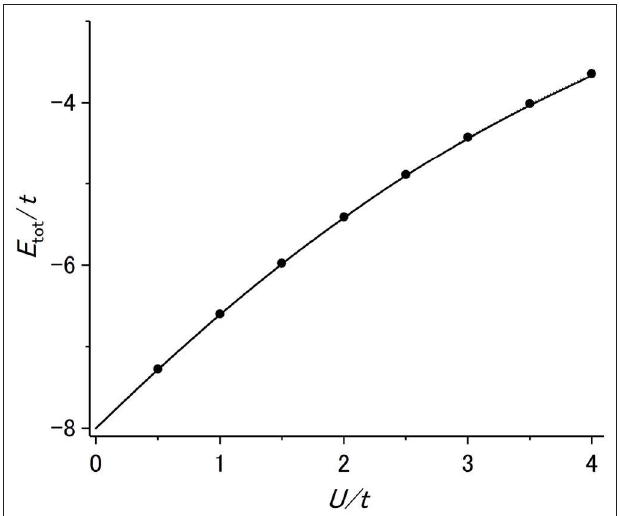
FIGURE 6 | Occupation probability of each s.p. state calculated in TDDM1 (circles and squares) as a function of U / t . The exact solutions are depicted with the solid, dotted, dashed and dot-dashed lines. Adapted from Tohyama [33] under the Creative Commons CCBY license.